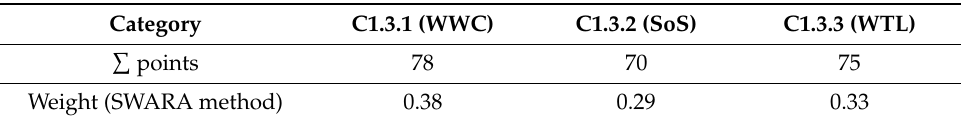
Table 12. Determination of weights of the wastewater coverage (WWC), wastewater treatment level (WTL) and the state of sewage system